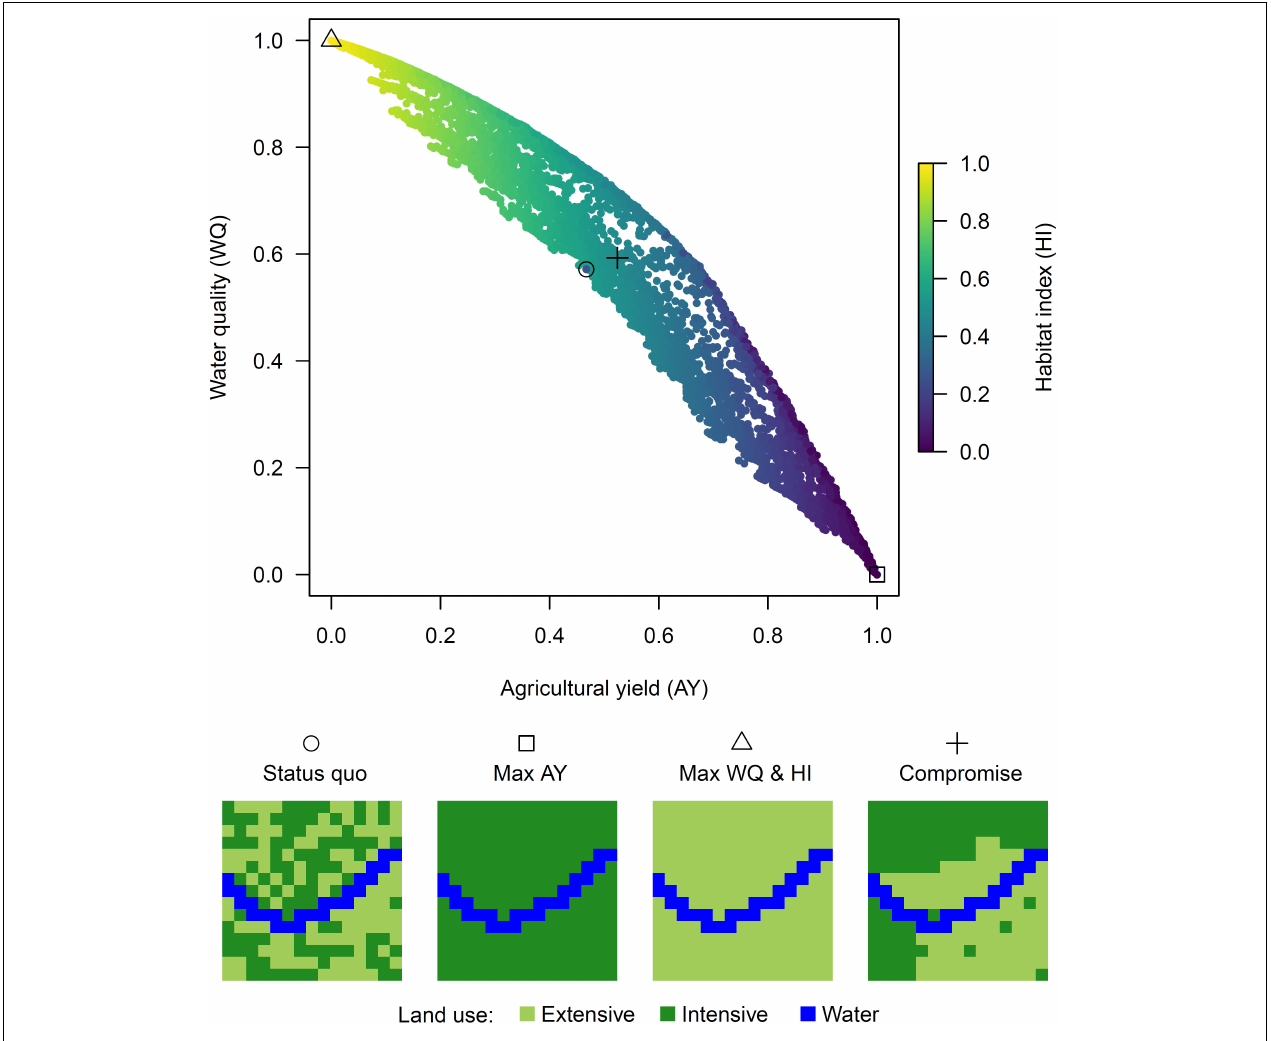
FIGURE 5 | Non-dominated solutions identified by CoMOLA with illustration of the status quo land use as well as maximum solutions and one compromise solution. “Max AY,” “Max WQ,” and “Max HI” are the solutions with maximal agricultural yield, water quality and habitat index, respectively. “Compromise” refers to the solution closest to the mean of each